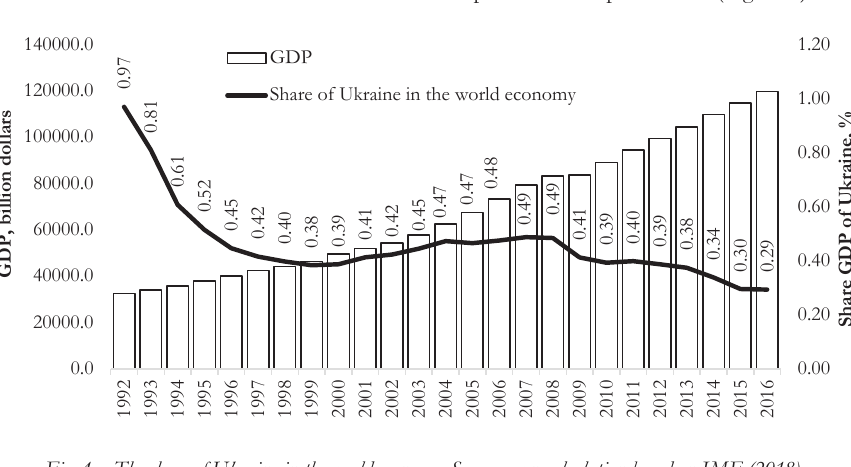
Fig. 4 – The share of Ukraine in the world economy. Source: own calculation based on IMF